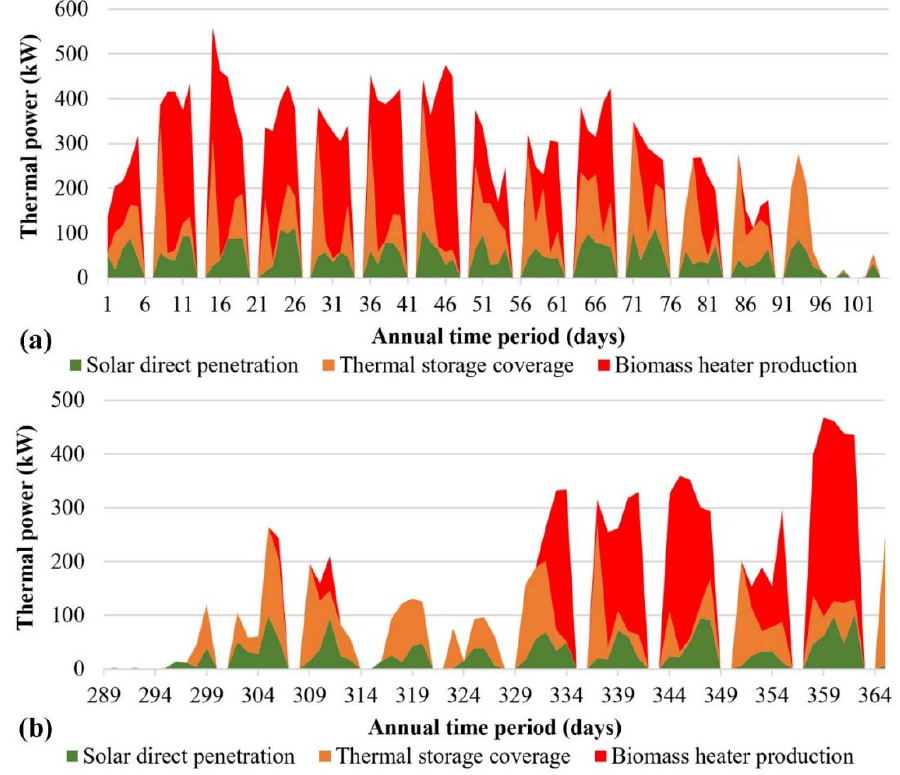
Figure 14. Thermal power production synthesis from the solar-combi system components for ( a ) the period from 1/1 to 15/4 and ( b ) the period from 15/10 to 31/12.